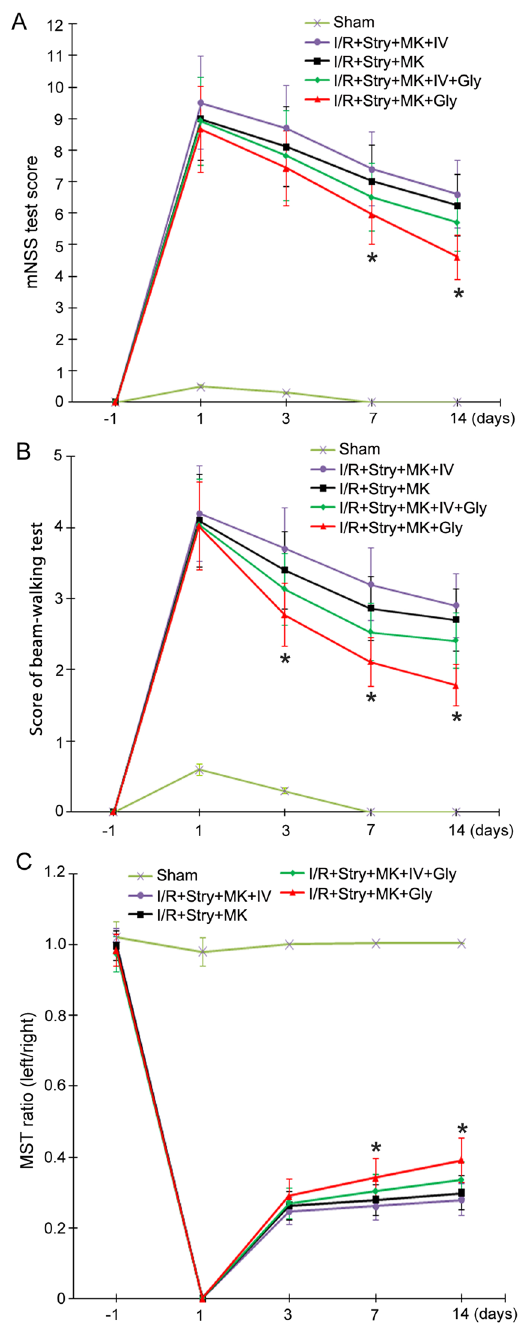
Figure. 7. Akt inhibitor IV prevents glycine-induced functional recovery of ischemic stroke animals. For all the three experiments, Glycine (100 µ g/100 g, icv) was administered at 3 h following I/R. Akt inhibitor IV (100 µ M, 2 µ l, icv) is injected with MK-801 and strychnine at 30 min before glycine injection. ( A ) Animals treated with glycine (100 µ g/100 g. icv) has lower scores of mNSS test at day 7 and 14 compared with I/R + Stry + MK + IV + Gly group (n = 10; ANOVA test, * P < 0.05, vs. I/R + Stry + MK + IV + Gly). ( B ) Animals treated with glycine has lower scores of beam-walking test at day 3, 7 and 14 compared with I/R + Stry + MK + IV + Gly group (n = 10; ANOVA test, * P < 0.05, vs. I/R + Stry + MK + IV + Gly). ( C ) Animals treated with glycine (100 µ g/100 g, icv) treatment has higher ratio in MST test at day 7 and 14 compared with I/R + Stry + MK + IV + Gly group (n = 10; ANOVA test, * P < 0.05, vs. I/R + Stry + MK + IV + Gly). Stry: Strychnine; Gly: glycine; MK: